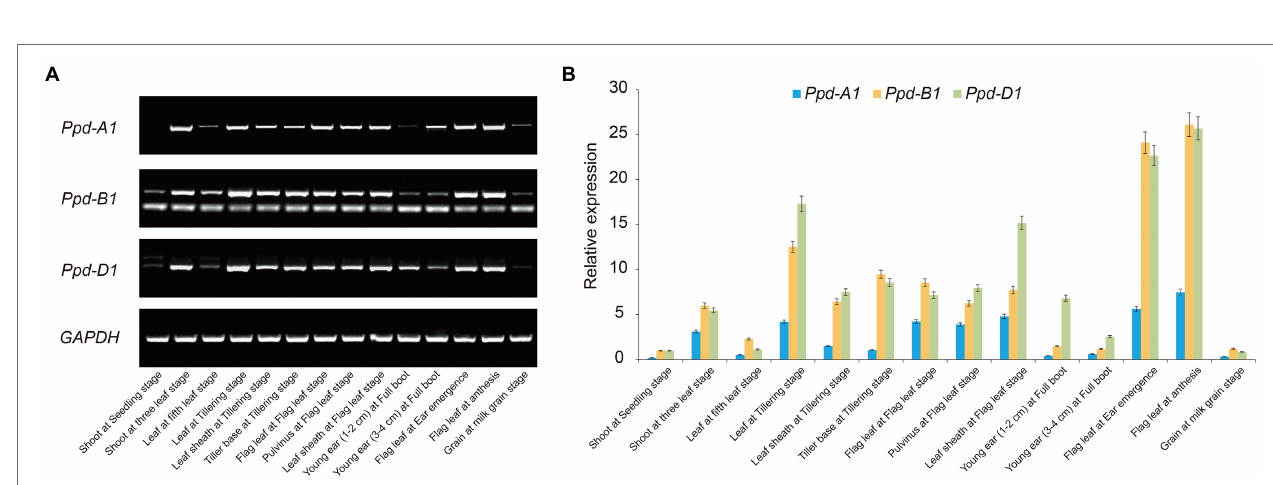
FIGURE 2 | Expression patterns of Photoperiod-1 ( Ppd-1 ) in different organs at different developmental stages of hexaploid wheat “Chinese Spring” under LD conditions. (A) Expression of Ppd-A1 , Ppd-B1 , and Ppd-D1 was analyzed by reverse transcription PCR (RT-PCR). Total RNAs were isolated from various organs of hexaploid wheat “Chinese Spring” at the seedling stage, three-leaf stage, tillering stage, flag leaf stage, full boot stage, ear emergence stage, anthesis, and milk grain stage. (B) Expression of Ppd-A1 , Ppd-B1 , and Ppd-D1 was analyzed by quantitative real-time PCR (qPCR). The glyceraldehyde-3-phosphate dehydrogenase ( GAPDH ) gene was used as an endogenous control. The data are the means of three independent